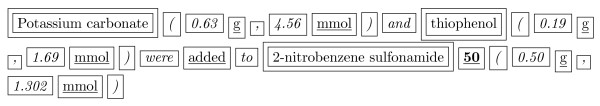
English POS Tagging.